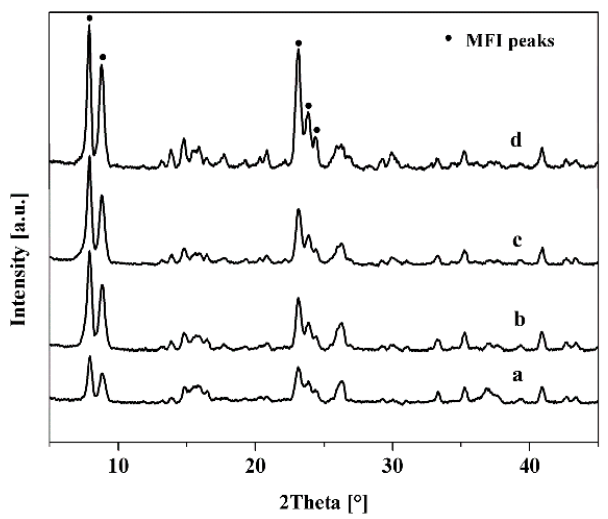
Figure 8. XRD patterns of TS-1 zeolite membranes with with different seeded crystals concentration suspension. ( a ) 2%, M-7; ( b ) 3%, M-8; ( c ) 5 catalytic %, M-3; ( d ) 7%, M-9.